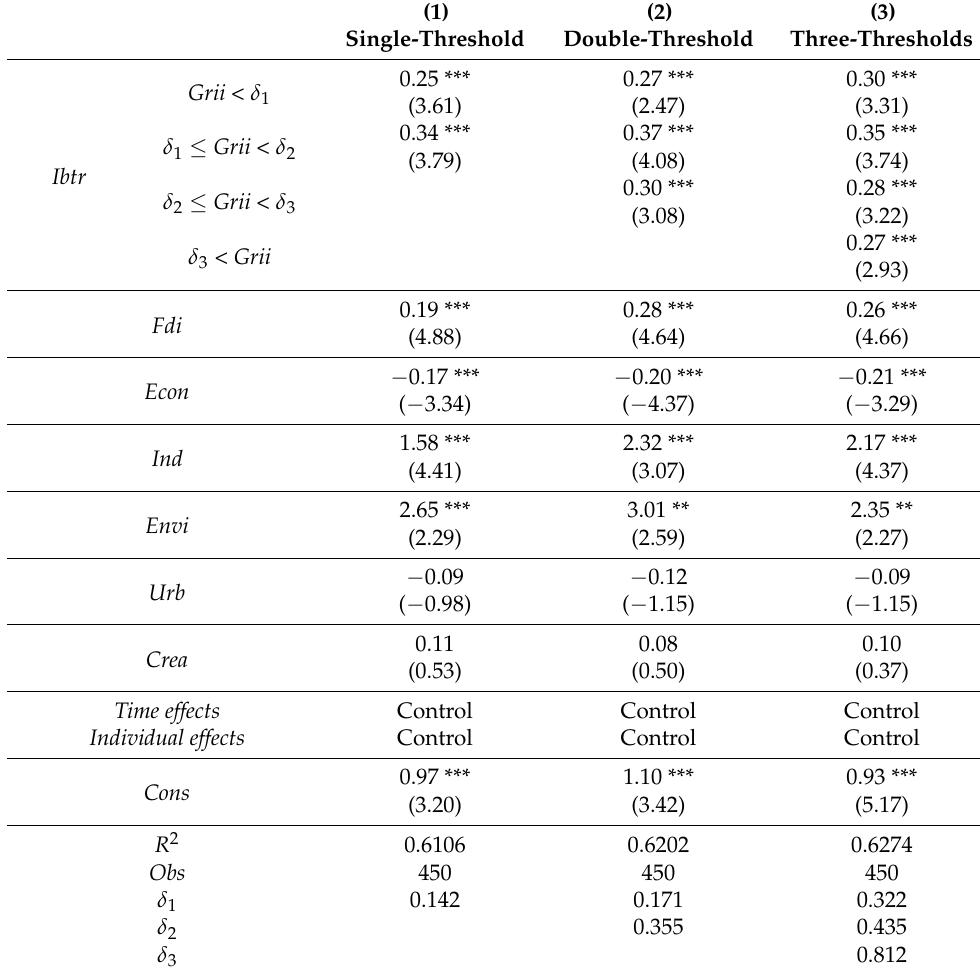
Table 4. Threshold effect results: From the perspective of green innovation factor